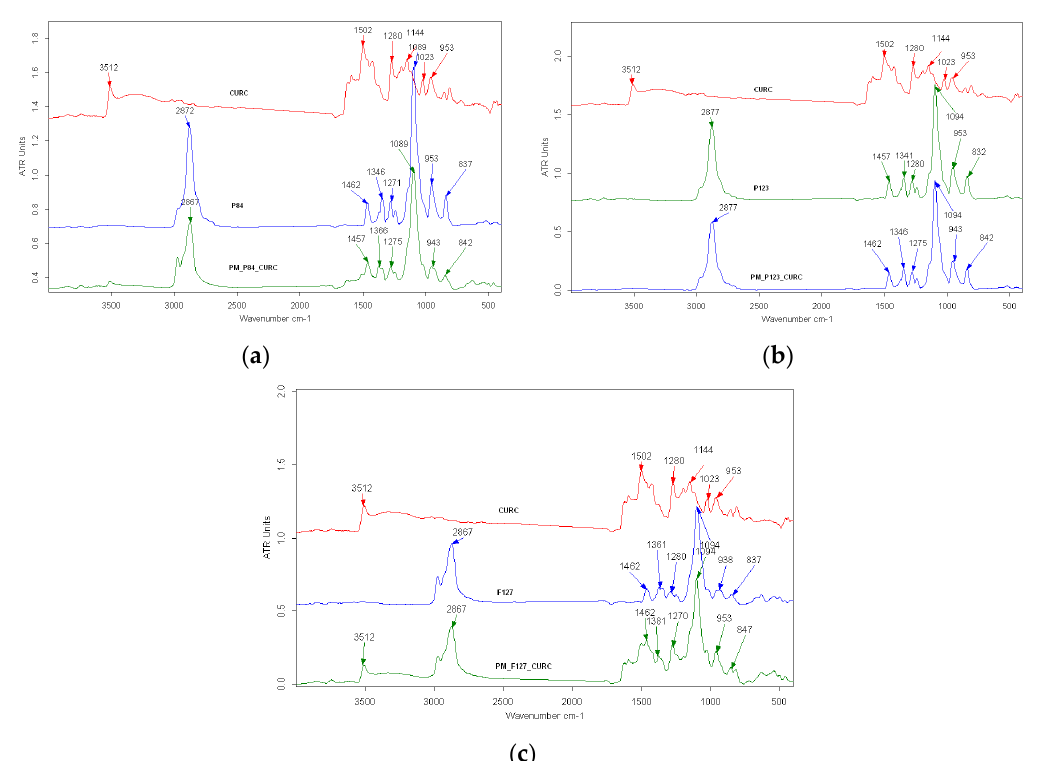
Figure 3. FTIR spectra of polymeric micelles with and without encapsulated Curcumin ( a ) Pluronic P84; ( b ) Pluronic P123; ( c ) Pluronic F127.